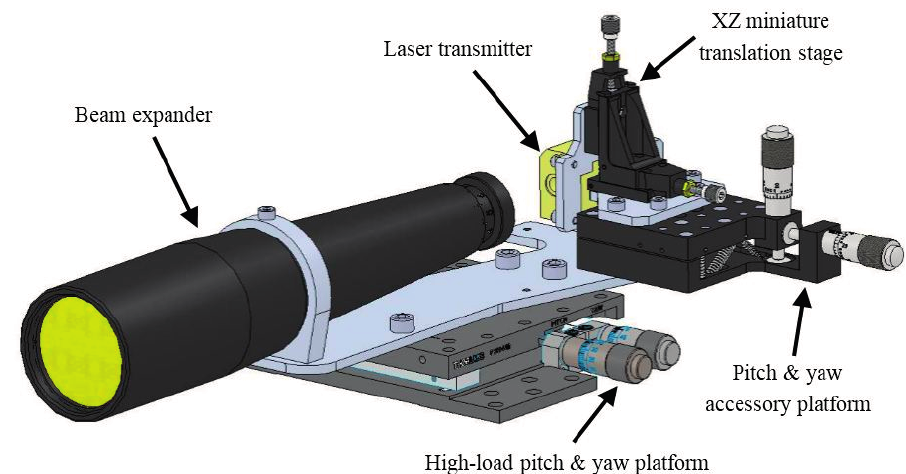
Figure 6. CAD 3D model of the optomechanical emission